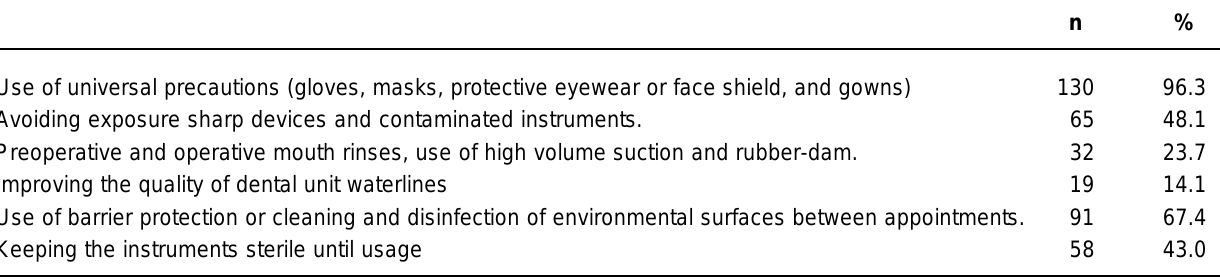
TABLE 3- Preferred methods to prevent the transmission of infections